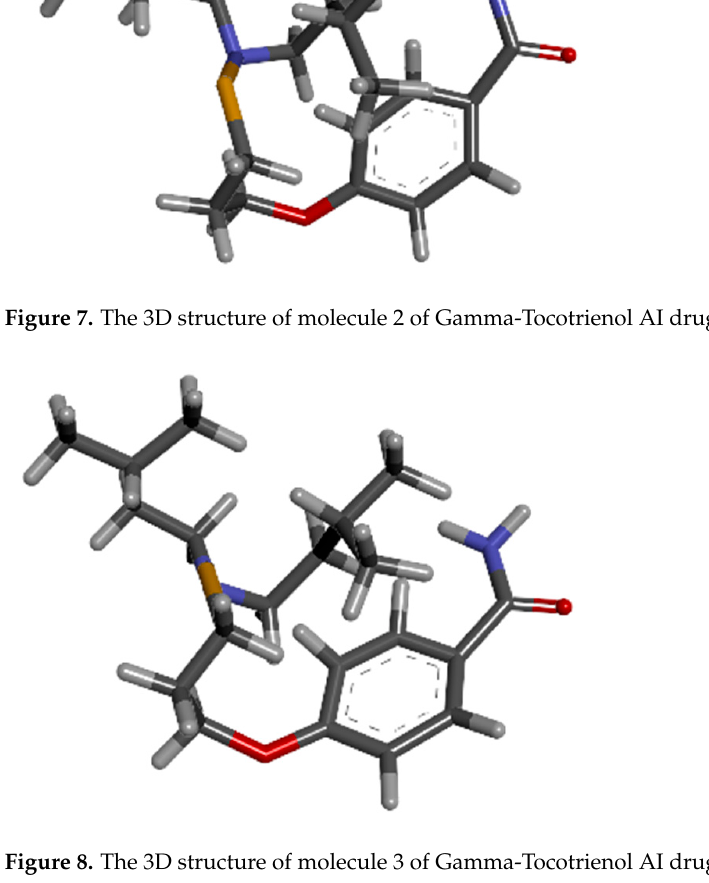
Figure 8. The 3D structure of molecule 3 of Gamma-Tocotrienol AI drug design from WADDAICA.